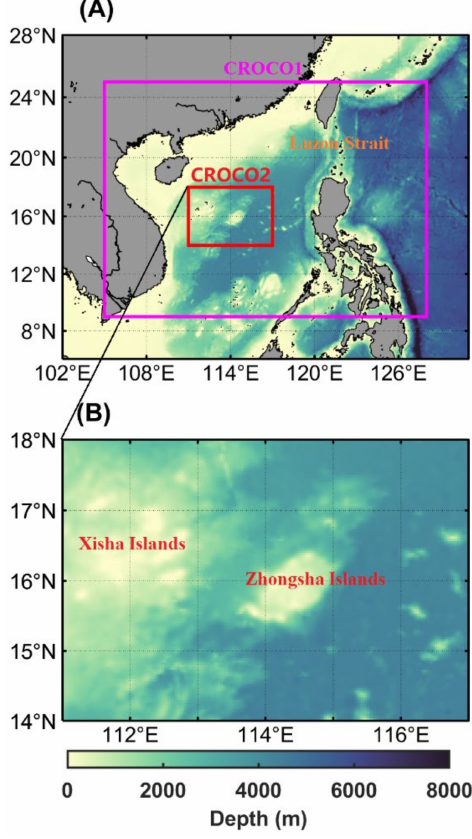
Figure 1. Topography in domains of simulation and the nested models at horizontal resolutions of ( A ) ~5 km (CROCO1) and ( B ) ~1 km (CROCO2),